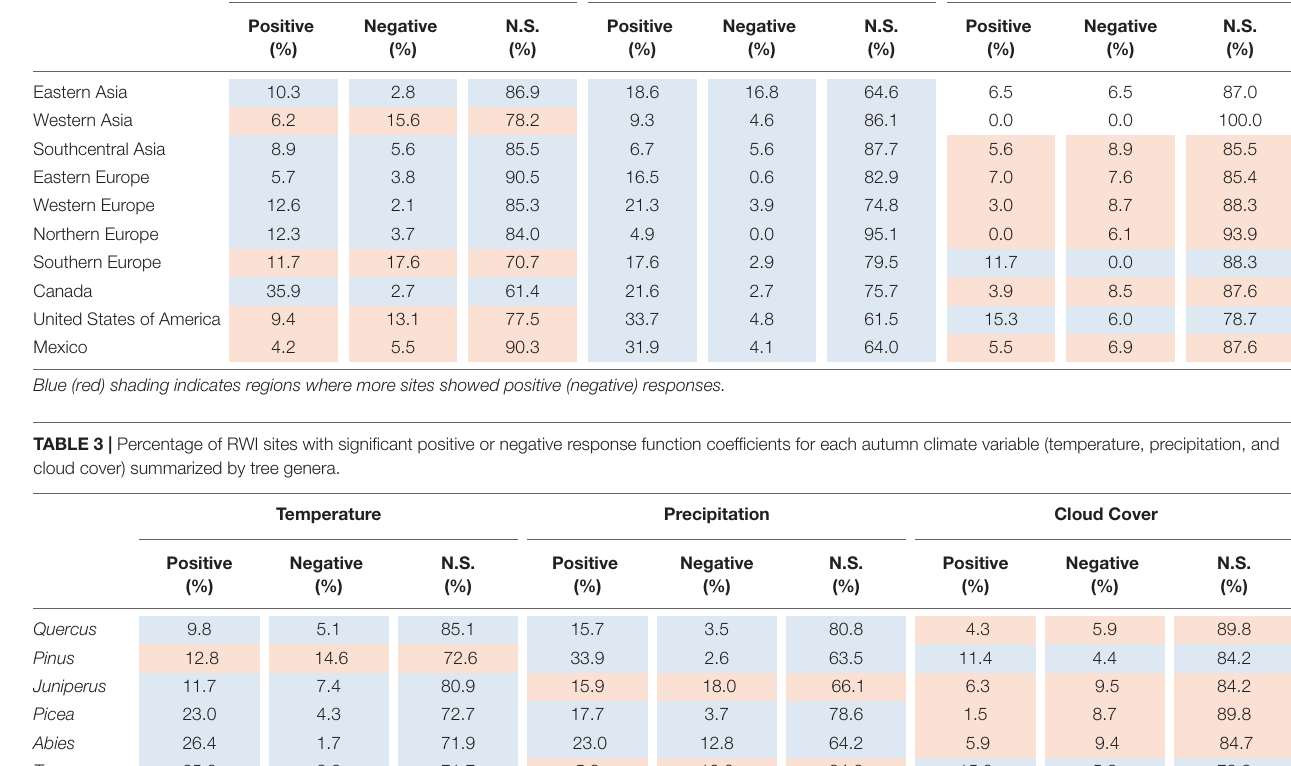
Temperature Precipitation Cloud Cover Positive Negative N.S. Positive Negative N.S. Positive Negative N.S. (%) (%) (%) (%) (%) (%) (%) (%) (%)